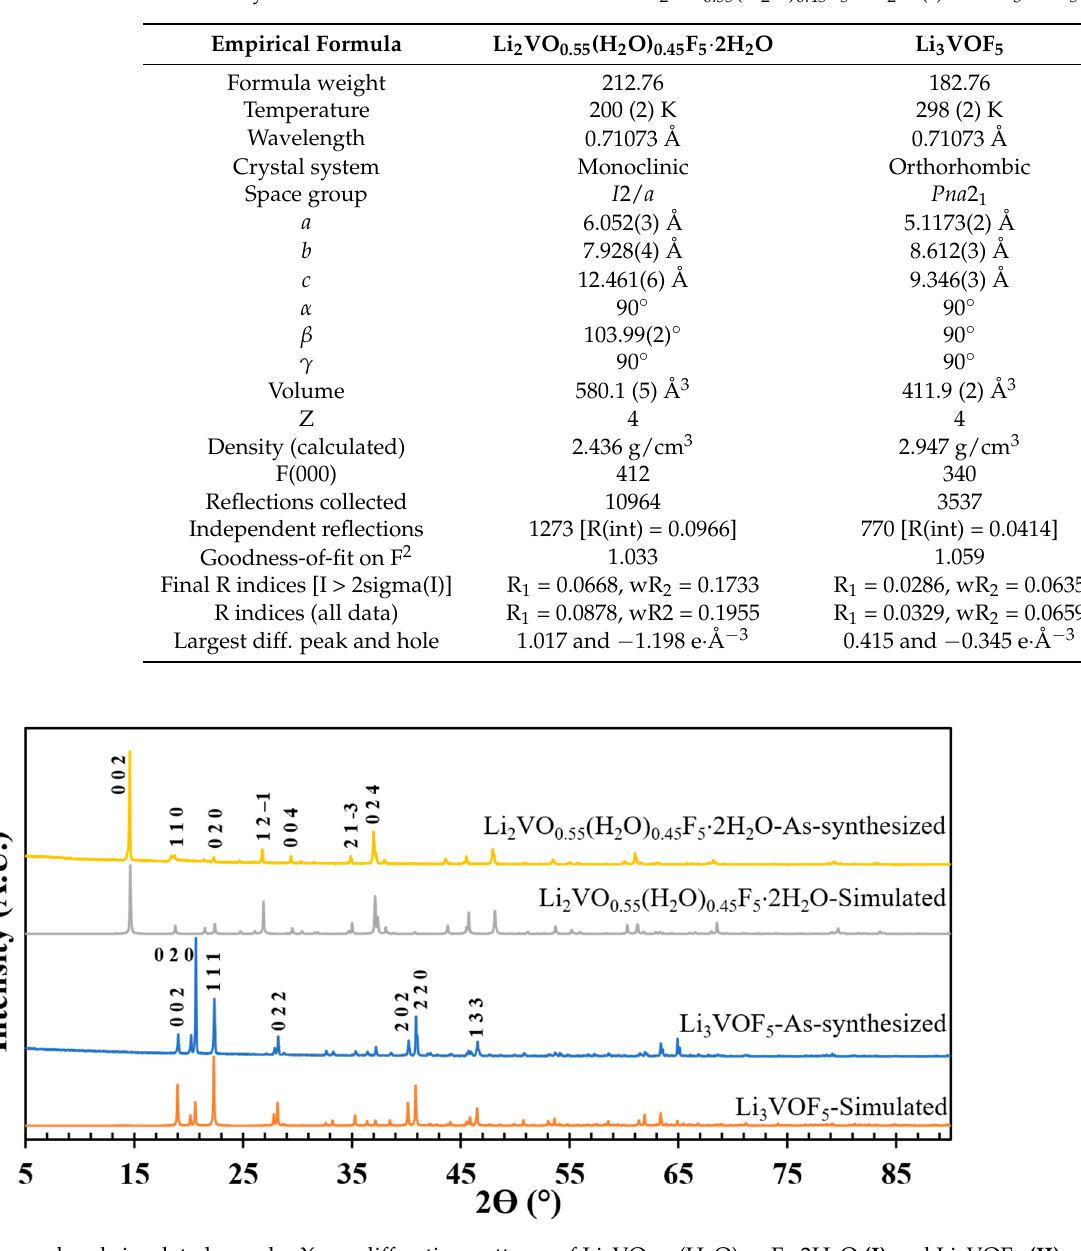
· 2H 2 VO 0.55 (H 2 O) 0.45 F 5 2 O (I) and Li 3 VOF 5 (II)